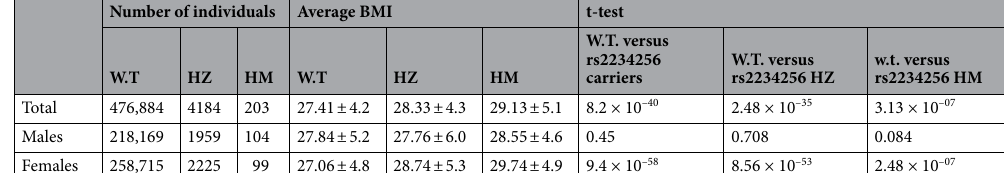
Number of individuals Average